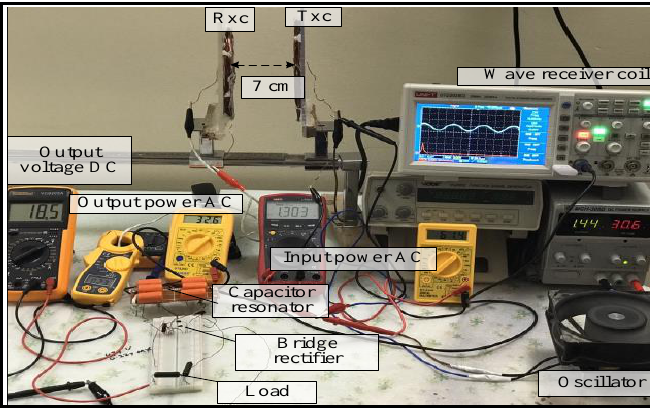
Figure 6. A snapshot of the MRC system at 7 cm for the second topology under load. Sensors 2020 , 20 , x FOR PEER REVIEW